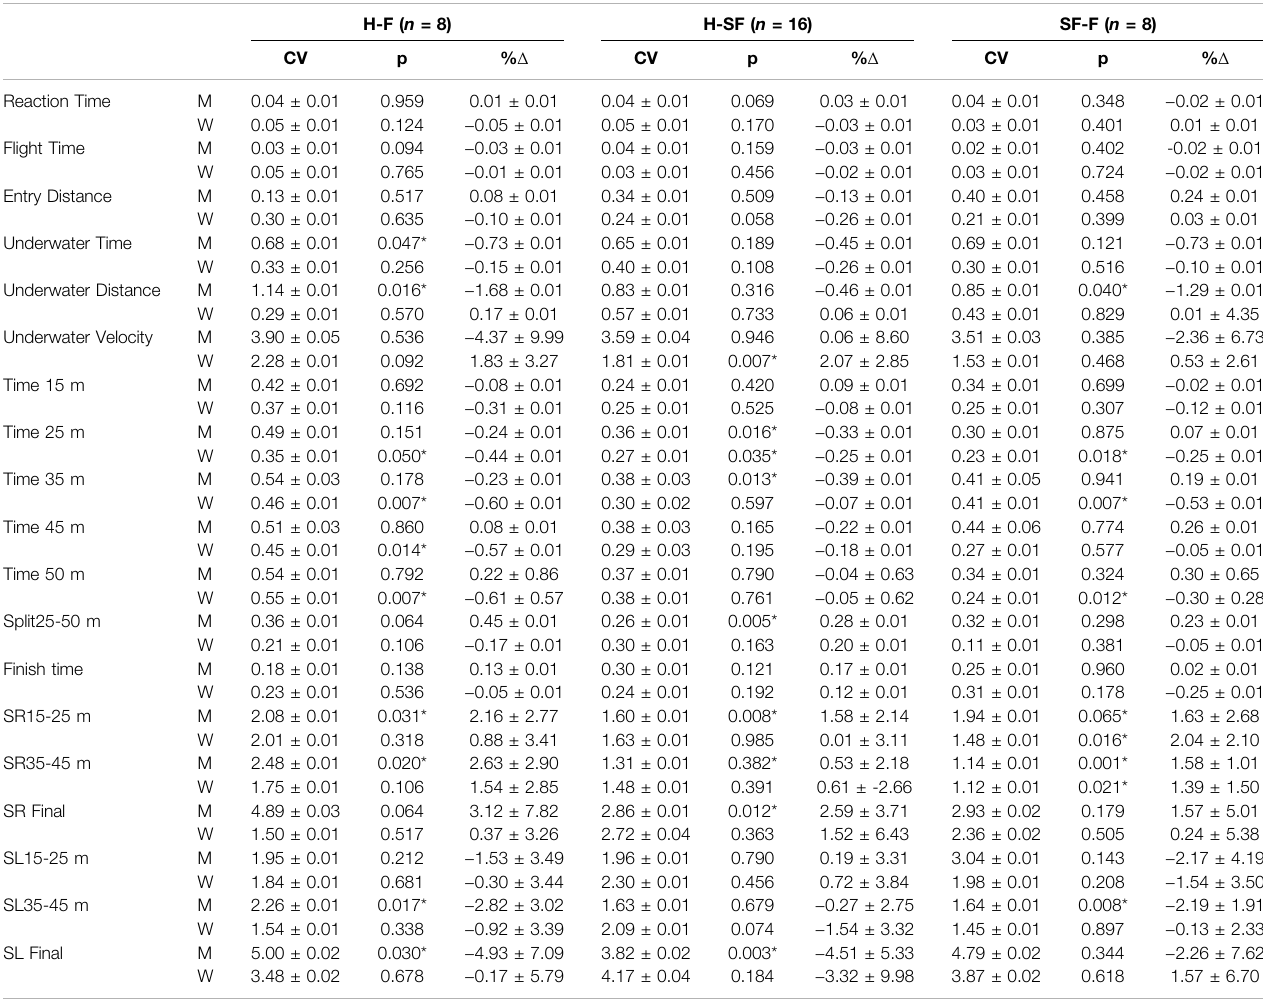
TABLE 7 | Breaststroke intra-athlete ’ s coef fi cient of variation (CV) and relative change in performance (% Δ ). Men (M); Women (W); Heat (H); Semi- fi nal (SF); Final (F) (LEN European Senior Championships 2021). H-F ( n = 8)